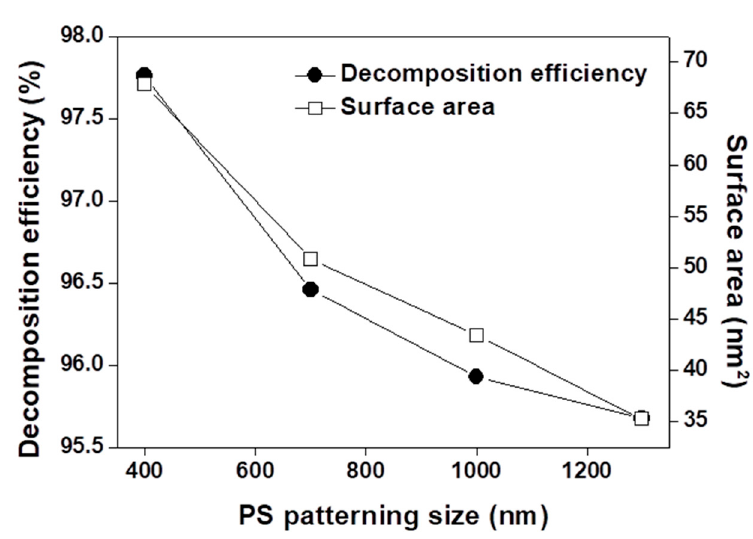
Figure 6. The initial photodegradation efficiency of PS-patterned films irradiated with a UV lamp for 25 min and the variations of surface area among the PS-patterned films.